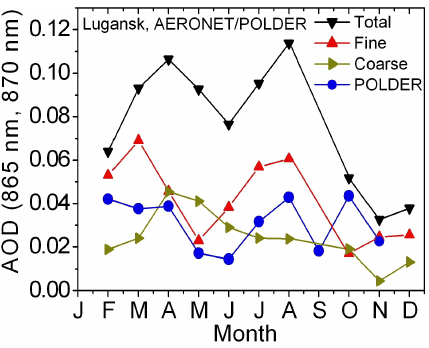
Figure 5. The AOD season variation over Lugansk by the AOD (870nm) for total, fine and coarse mode from the AERONET site data and the POLDER AOD (865nm) data.